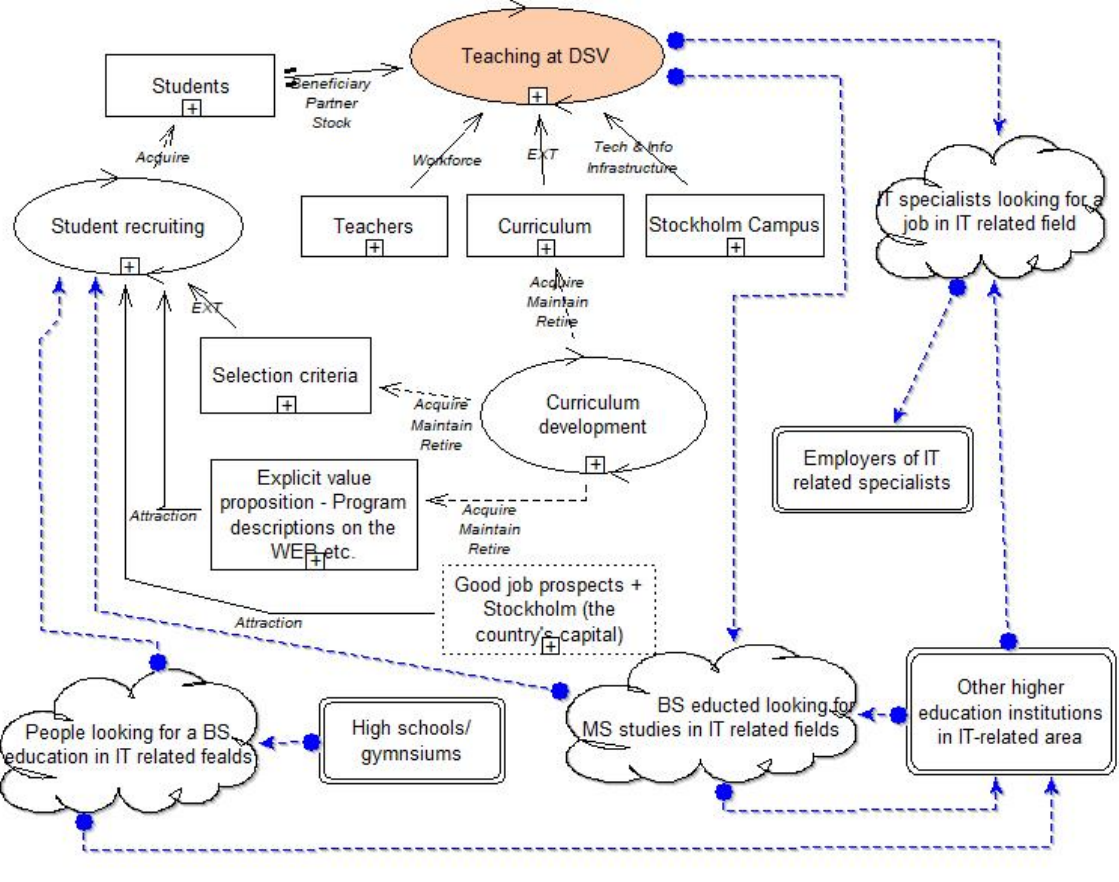
Figure 3. A fragment of FEM for